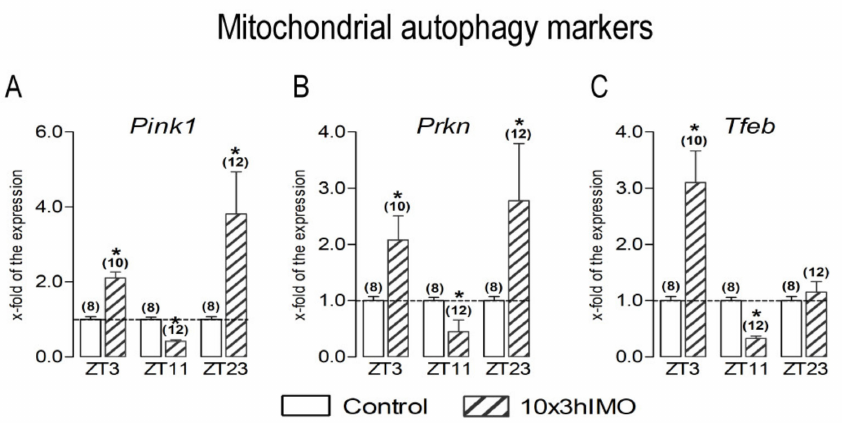
Figure 6. Different transcriptional profiles of mitochondrial autophagy markers in spermatozoa of repeatedly stressed adult rats at different time points. Spermatozoa isolated from undisturbed and repeatedly stressed rats were used for RNA isolation and further analysis of the transcriptional profile of markers of mitochondrial autophagy. Data bars are mean ± SEM values of two independent in vivo experiments (n = number of rats). Statistical significance was set at level p < 0.05: * vs. control group of the same time point.